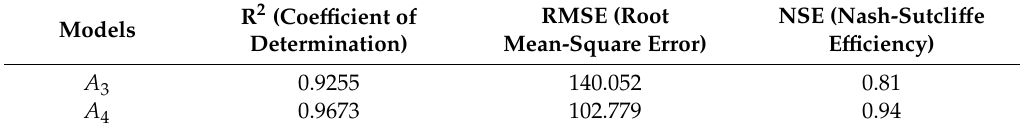
Table 5. Performance comparison of A 3 and A 4 models when the water level is greater than 25